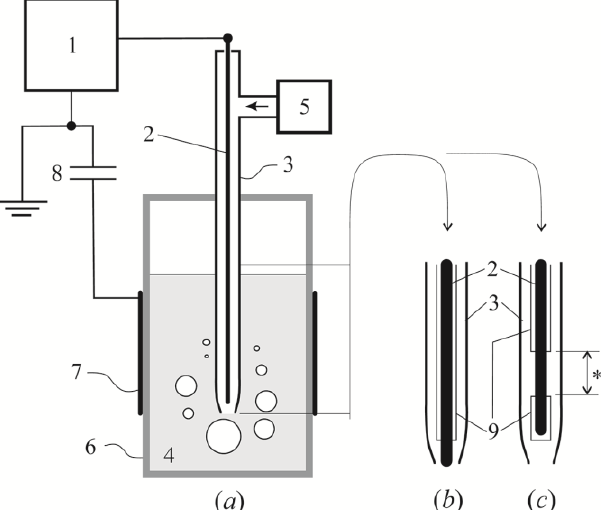
Figure 1. Block diagram of the experimental setup: general view ( a ) and zoomed sketches (indicated by arrows) of two design options of the high-voltage part ( b , c ). 1 — power supply; 2 — high-voltage electrode; 3 — air feeding tube; 4 — aqueous solution; 5 — membrane air pump; 6 — quartz vessel; 7 — foil electrode; 8 — capacitor; 9 — dielectric shell; (*) – 10-cm-length section freed from the dielectric shell.